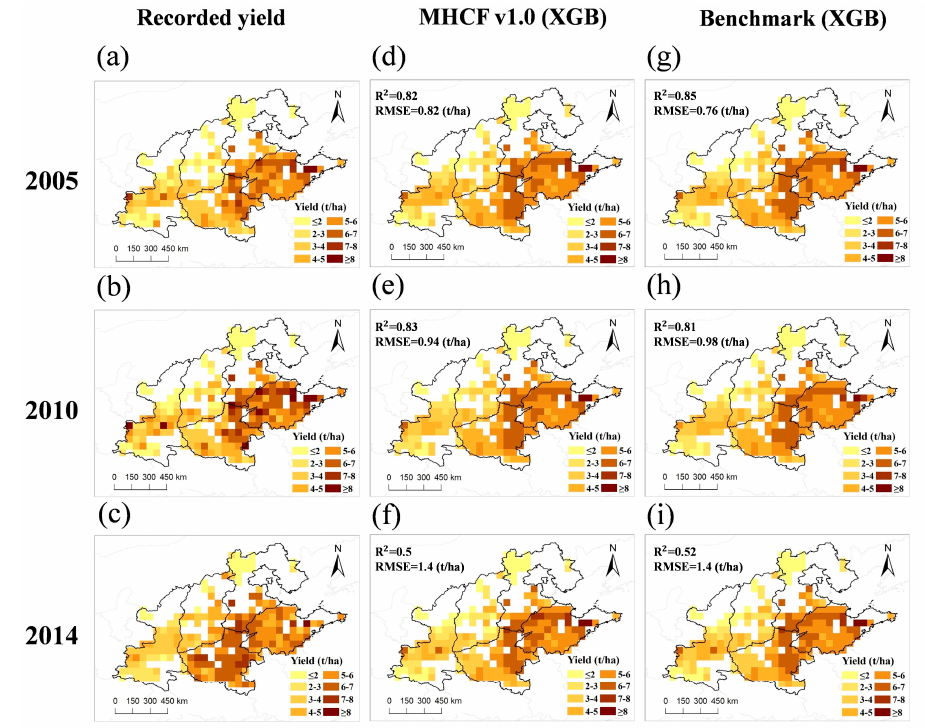
Figure 7. Spatial patterns of the yield predicted with XGBoost (2005, 2010, and 2014). ( a – c ) the recorded yield; ( d – f ) the yield predicted by MHCF v1.0; ( g – i ) the yield predicted by the Benchmark model.